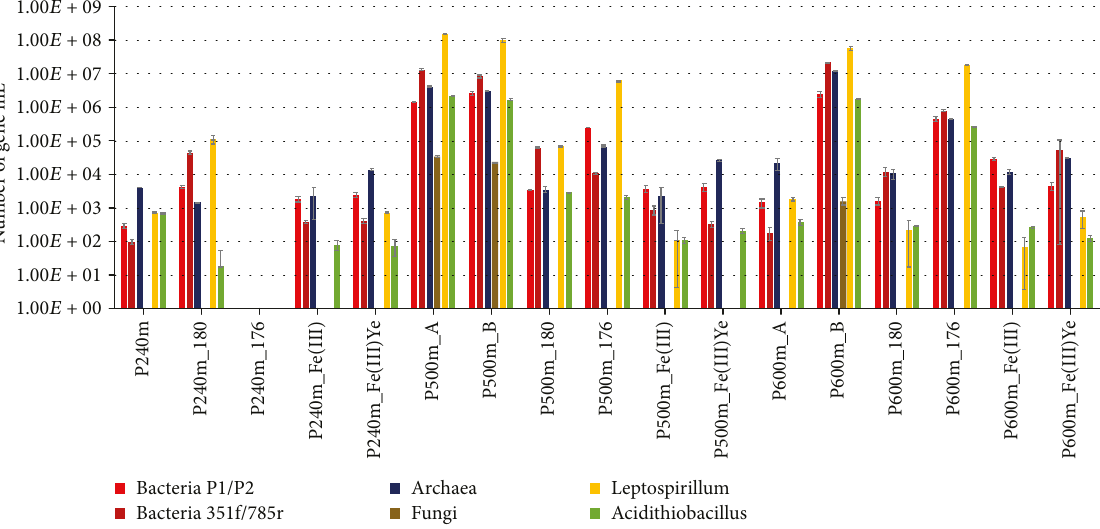
Figure 3: The number of bacterial (bright red – primers P1/P2, dark red – primers 358f/785r) and archaeal (blue) 16S rRNA genes, fungal 5.8S rRNA genes (brown), and the number of bacterial 16S rRNA genes belonging to Leptospirillum (yellow) and Acidithiobacillus (green) mL − 1 in the sample water and enrichment cultures. The e ffi ciencies of the qPCR assays (in order from left to right) were 2.01 (slope − 3.29), 2.10 (slope − 3.08), 1.65 (slope − 4.71), 1.88 (slope − 3.66), 1.96 (slope − 3.2), and 1.77 (slope −